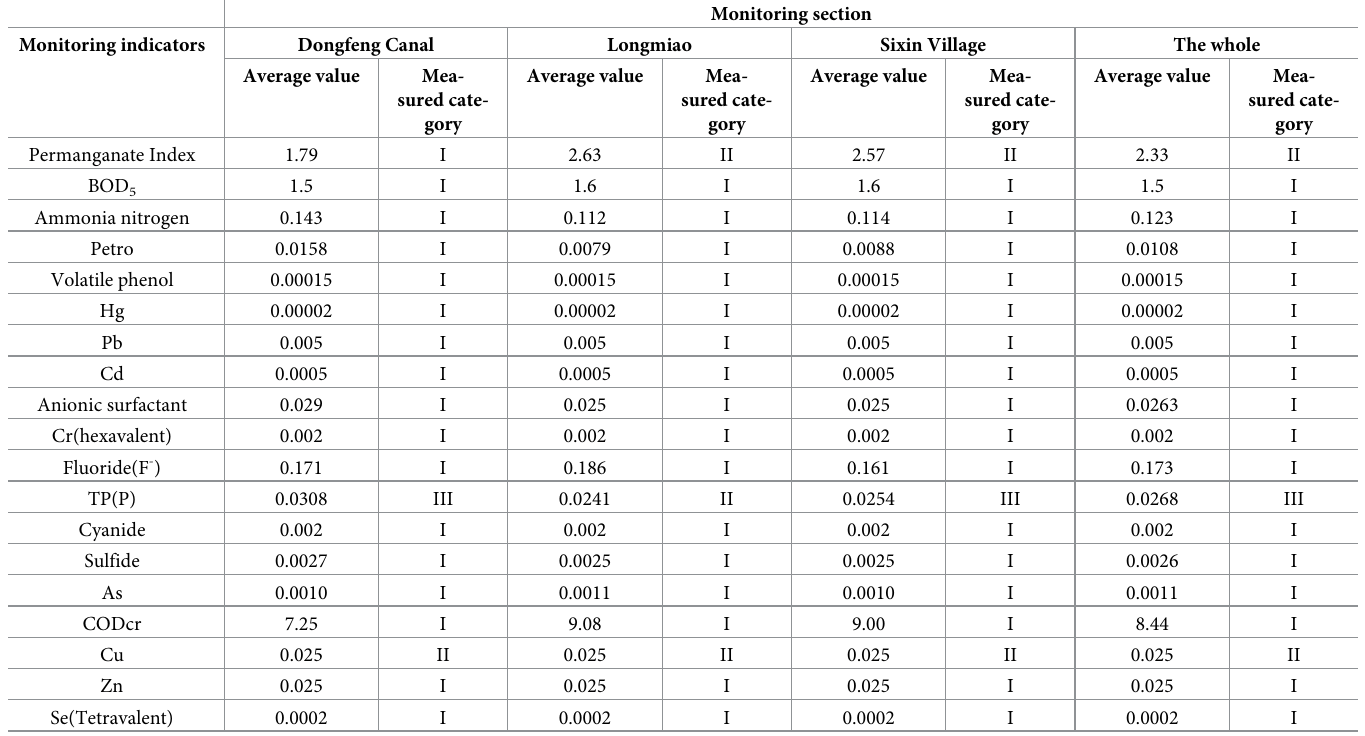
Table 3. Statistical results of various indicators in Heilongtan Reservoir in